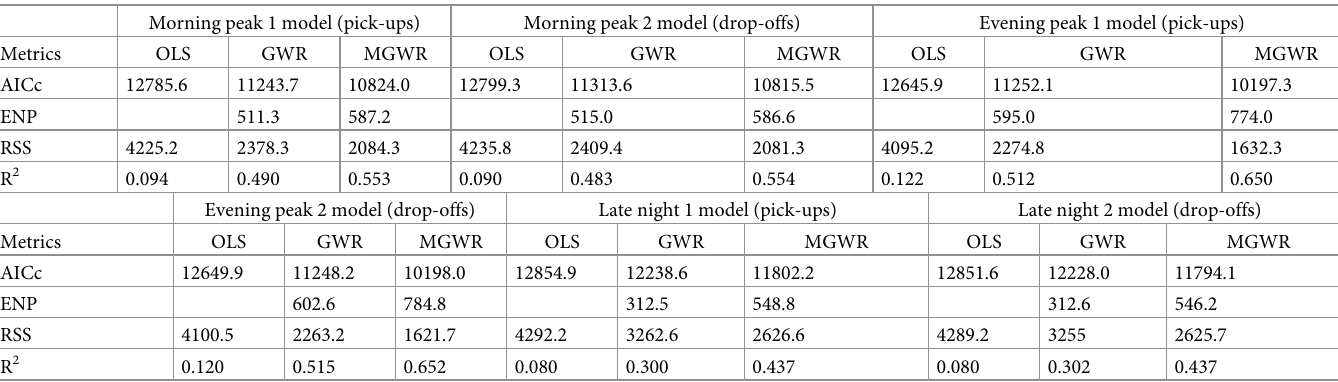
Table 2. Comparison between global and local